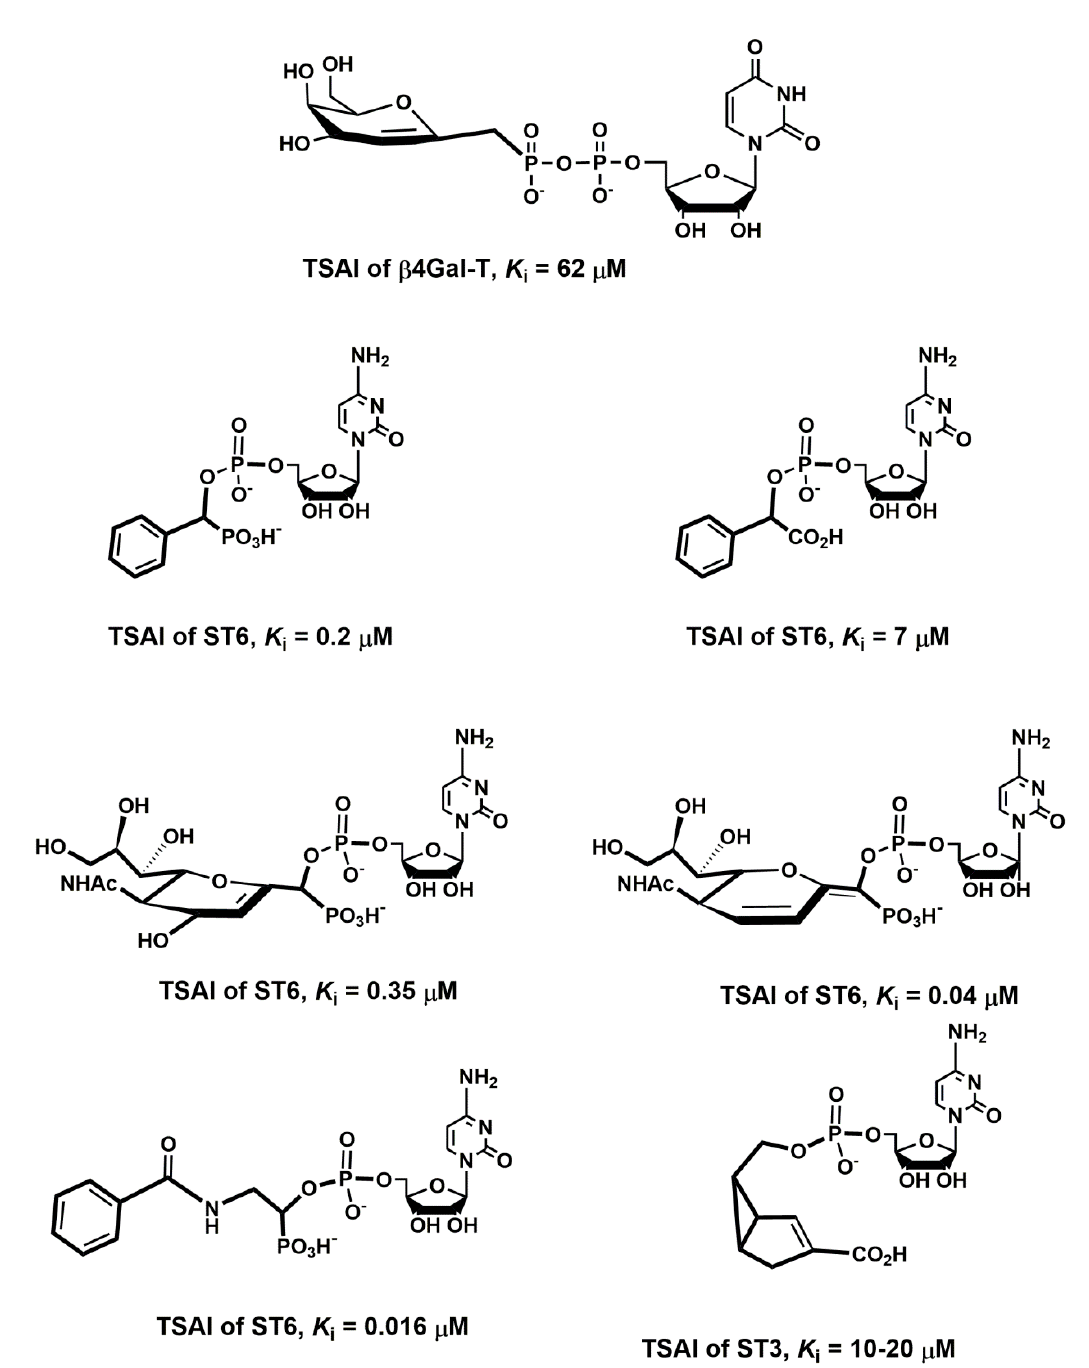
Figure 21. Schematic representation of selected transition state analog inhibitors.